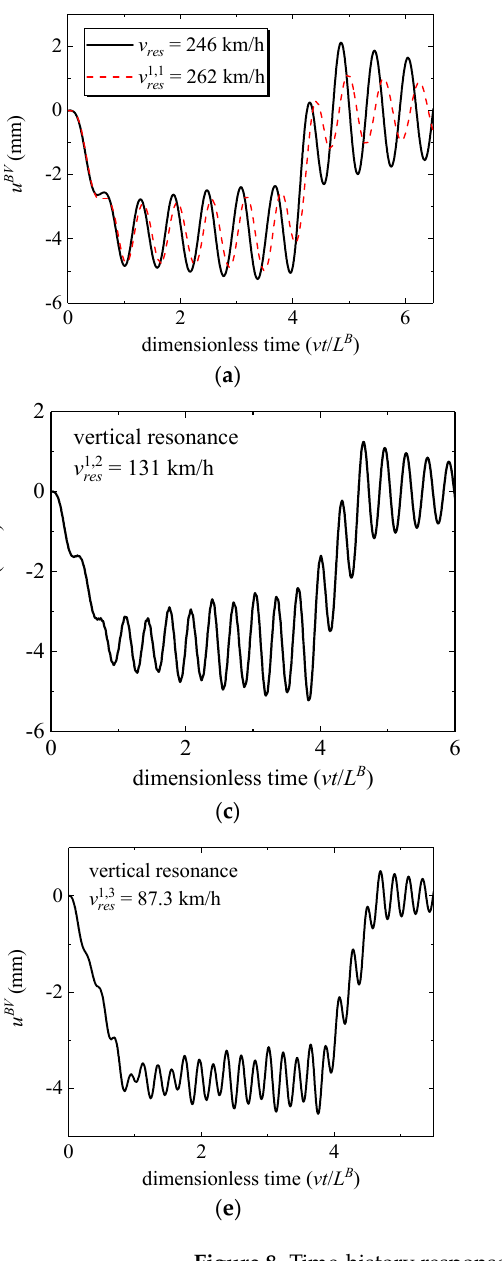
Figure 7. Dynamic impact factor (IF) of bridge spanning 25 m: ( a ) IF of vertical displacement; ( b ) IF of radial displacement 4.3. Time-History Response under Resonance